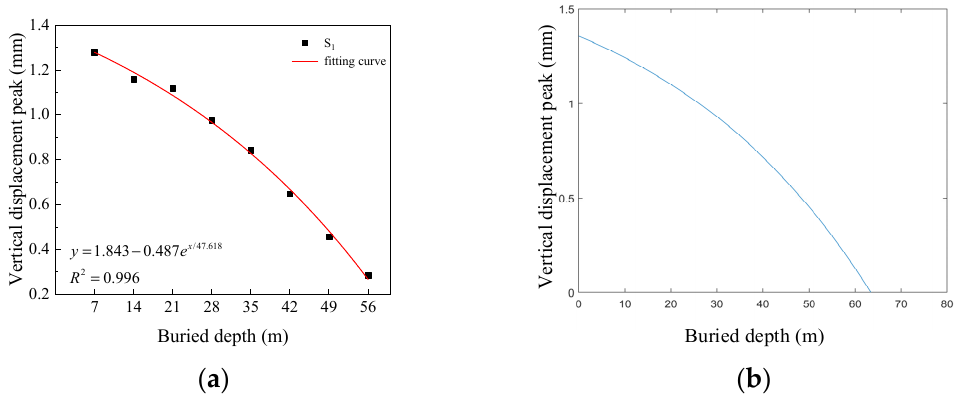
Figure 15. A fitted prediction curve; ( a ) peak vertical displacement of the roof; ( b ) fitted prediction